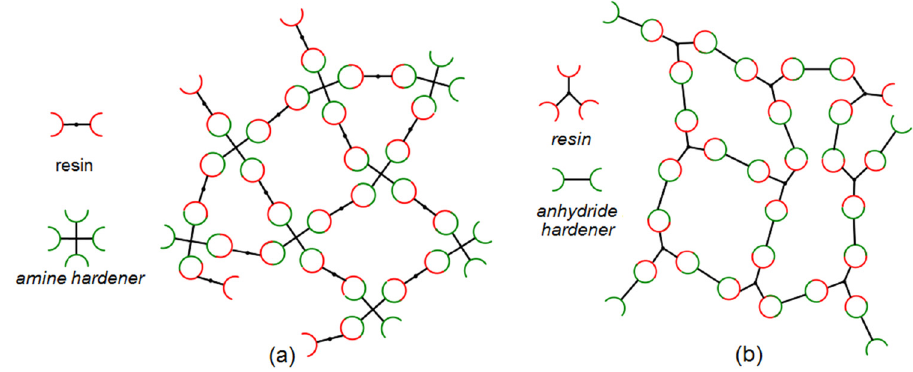
Figure 13: Reactivity diagram of epoxy resin DGEBA within ( a ) amine curing system and ( b ) anhydride curing system [ 60